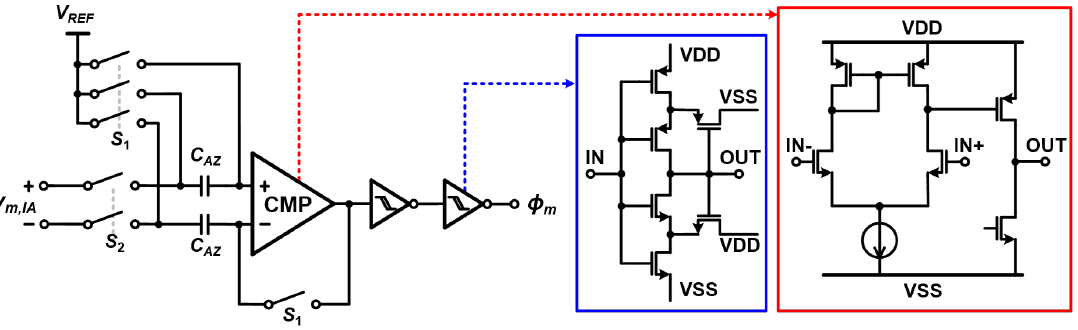
Figure 8. Circuit schematic of the